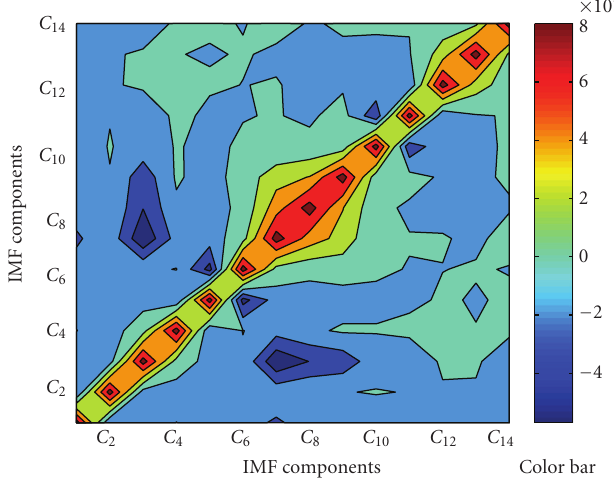
Figure 3.8. The values of the indices of orthogonality between all possible pairs of